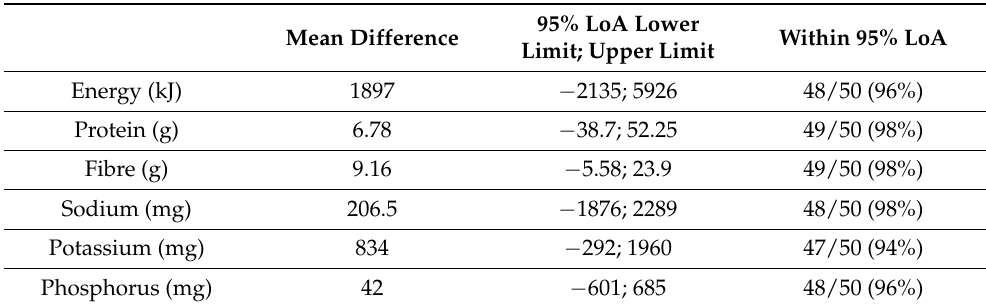
Table 3. Bland–Altman Index for Limit of Agreement (LoA) and mean difference between P-FFQ and 24 hr multi pass recall ( n = 50).